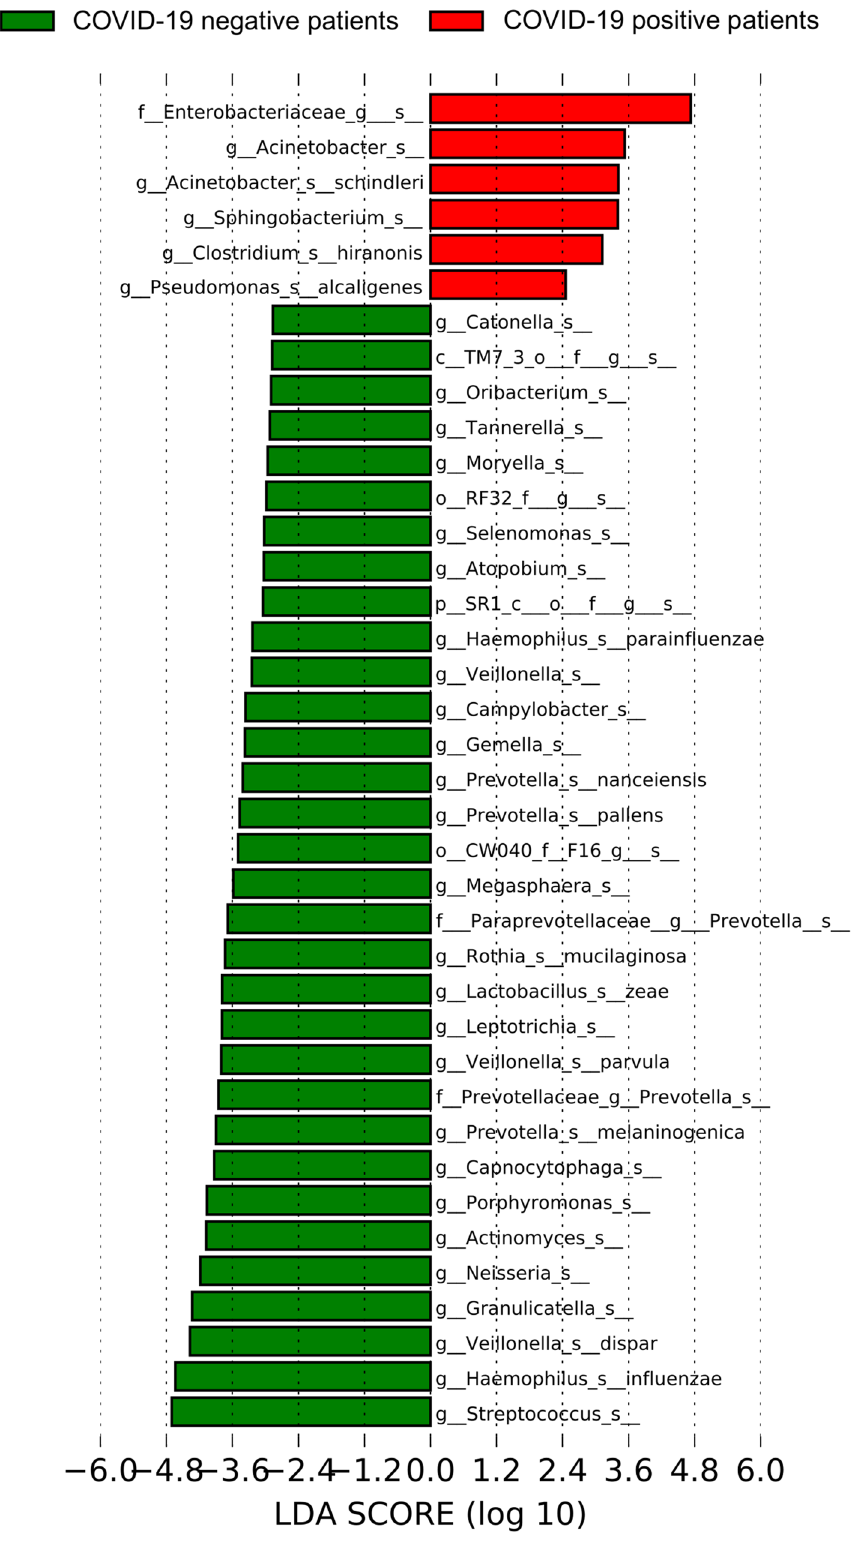
Figure 3. Plot from LDA LEfSE analysis. The plot was generated using the online Galaxy web platform tools at https:// hutte nhower. sph. harva rd. edu/ galaxy/. The length of the bar column represents the LDA score. The figure shows the microbial taxa with significant differences between the COVID-19 positive (red) and negative patients (green) (LDA score > 2) with their original identification